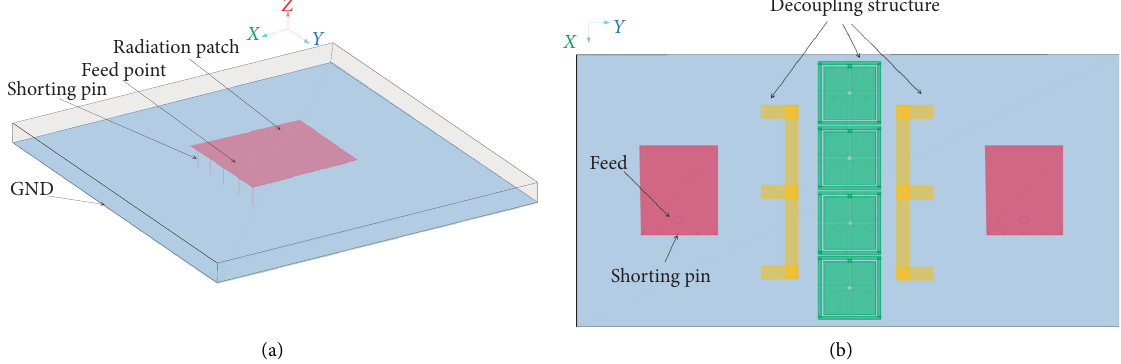
Figure 9: Geometry of the PIFA (a) antenna unit and (b) two antennas with decoupling structure.